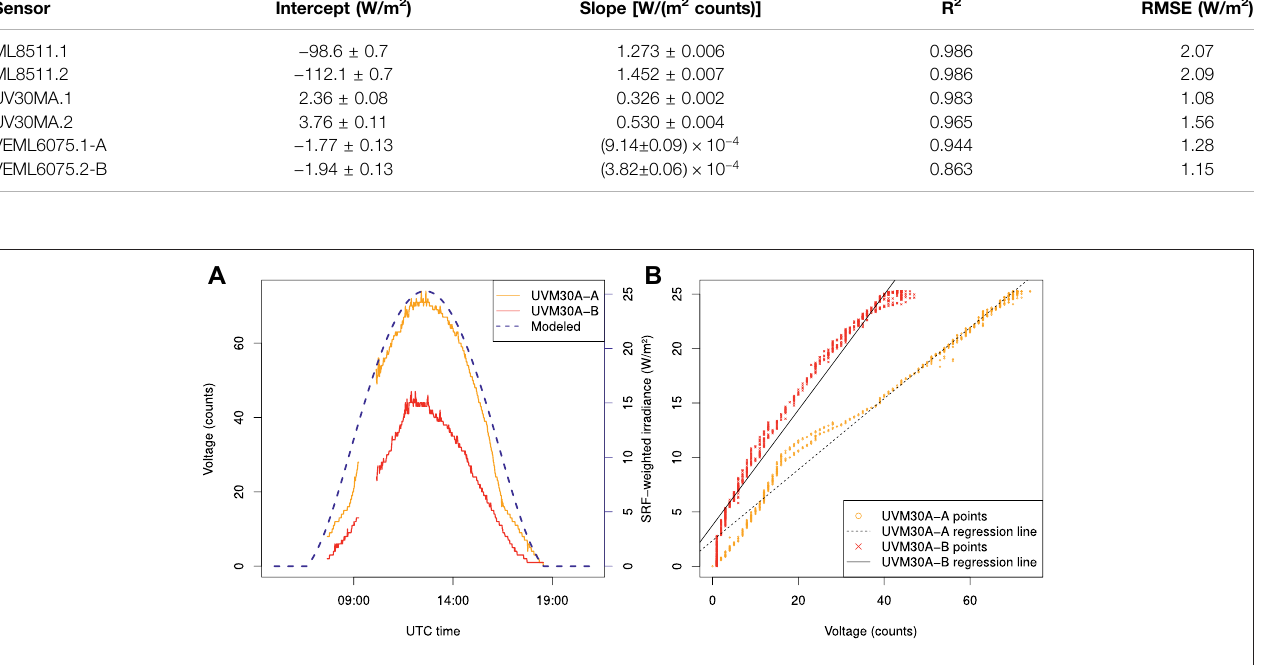
Frontiers in Environmental Science |